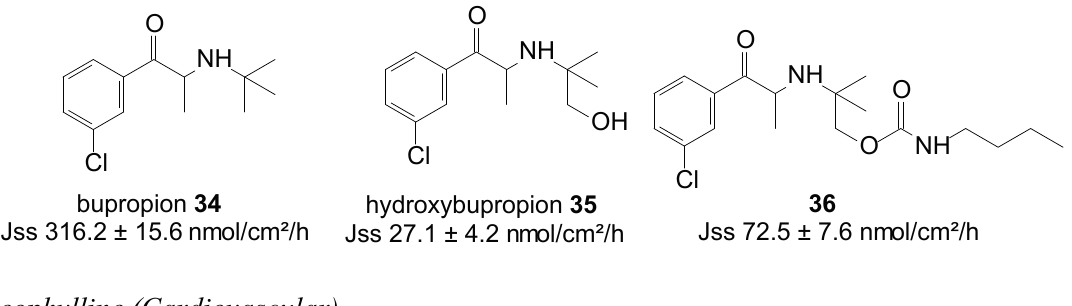
Figure 9. Bupropion, hydroxypropion and the carbamate prodrug of hydroxypropion. NHO Cl bupropion 34 Jss 316.2 ± 15.6 nmol/cm²/h